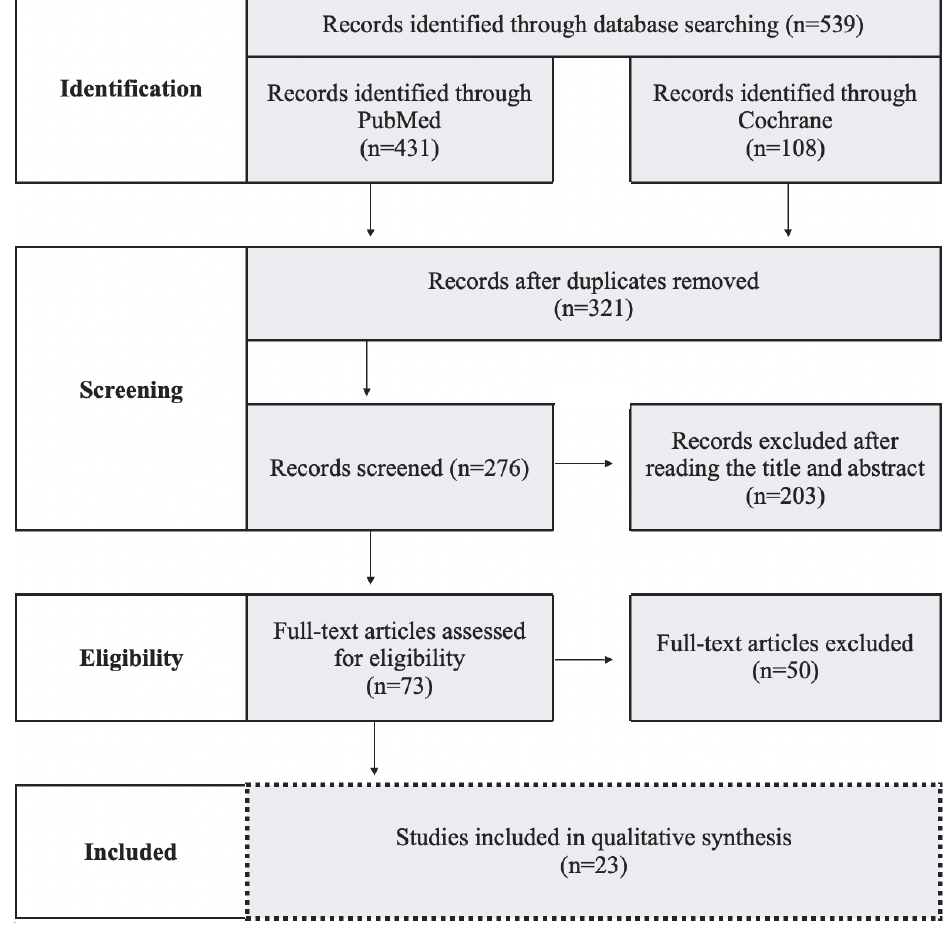
Figure 3. Flow diagram describing the study selection process.